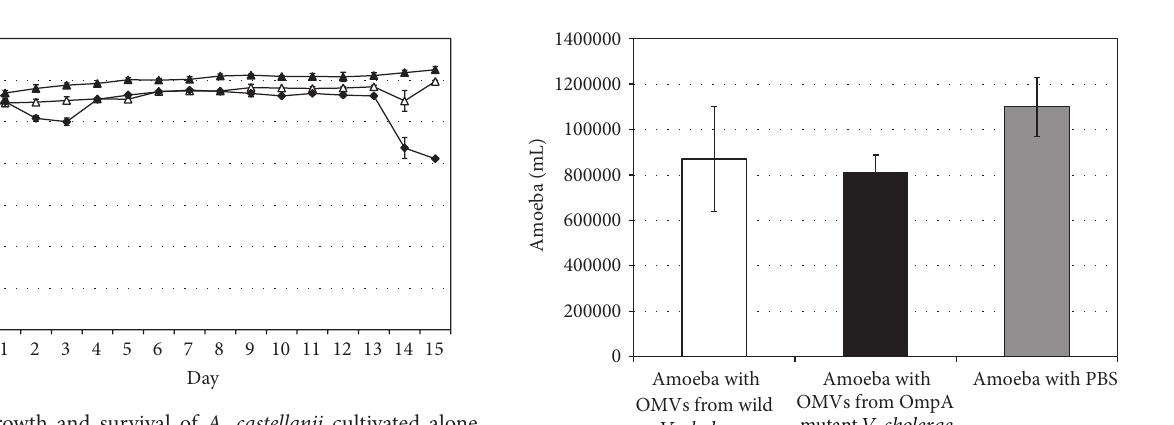
Figure 4: Growth and survival of A. castellanii cultivated alone (filled triangles), with wild-type V. cholerae (empty triangles) and with the OmpA mutant strain of V. cholerae (filled diamonds). Data represent mean ± SD from three different experiments.